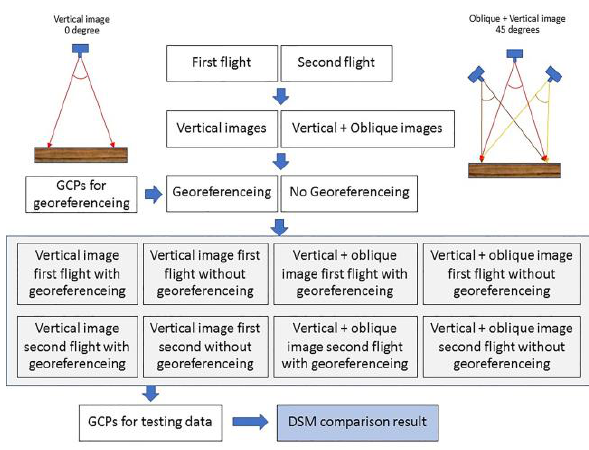
Figure 5. The experiment design of Quad-Rotor UAV